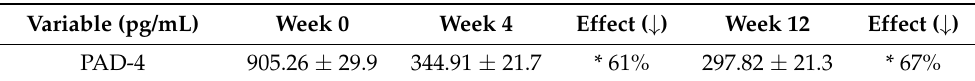
Table 7. Changes of PAD-4 level (pg/mL) during treatment ( n = 50). * indicates a statistically significant difference ( p < 0.05).